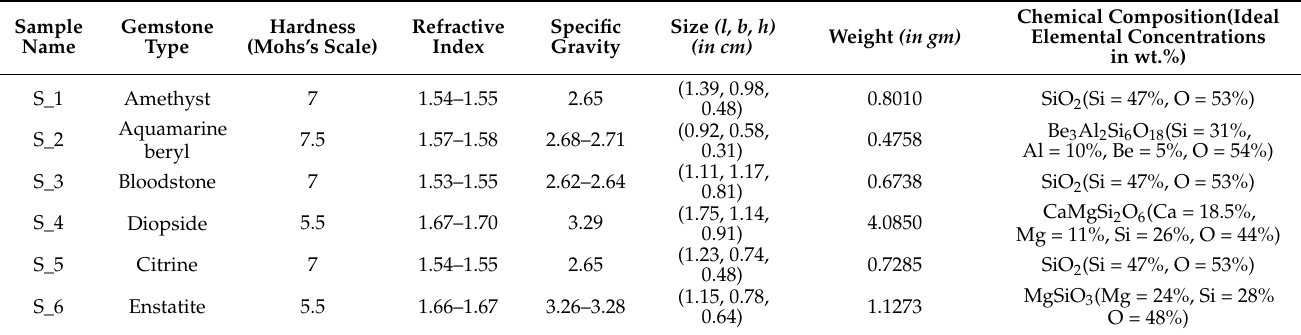
Table 1. Characteristics of the gemstone samples.